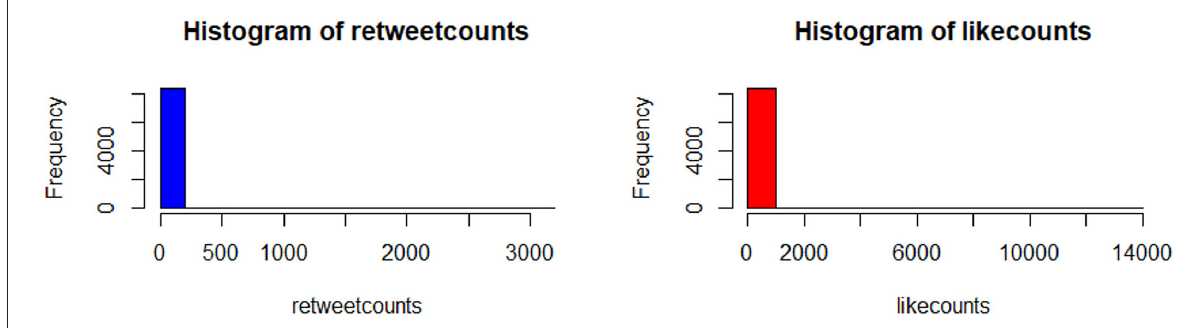
FIGURE14 The histogram of the tweets shows an abundance of zeros.